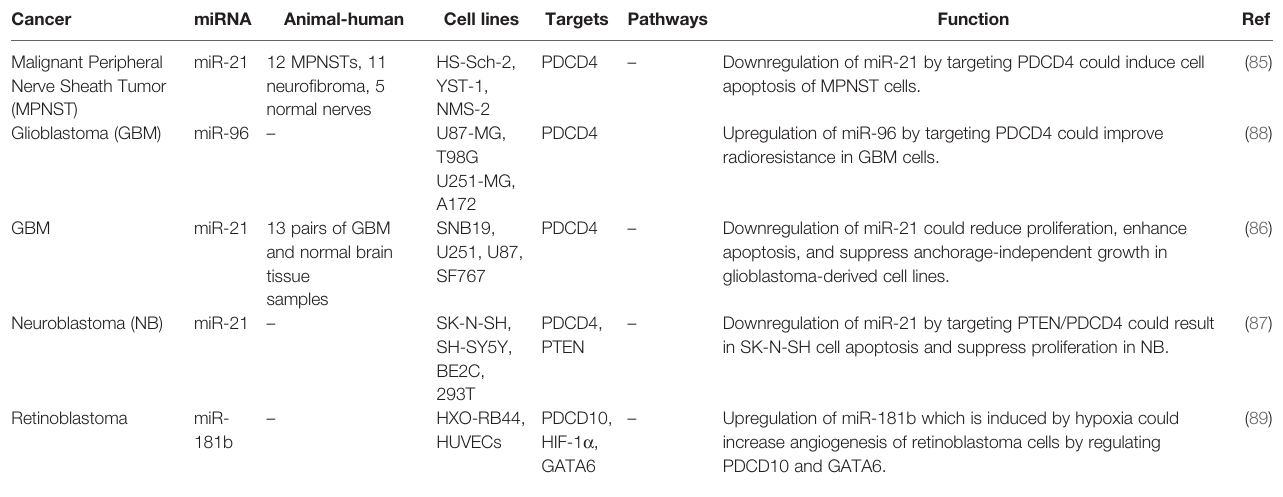
TABLE 8 | Interaction between miRNAs and PDCD nervous system